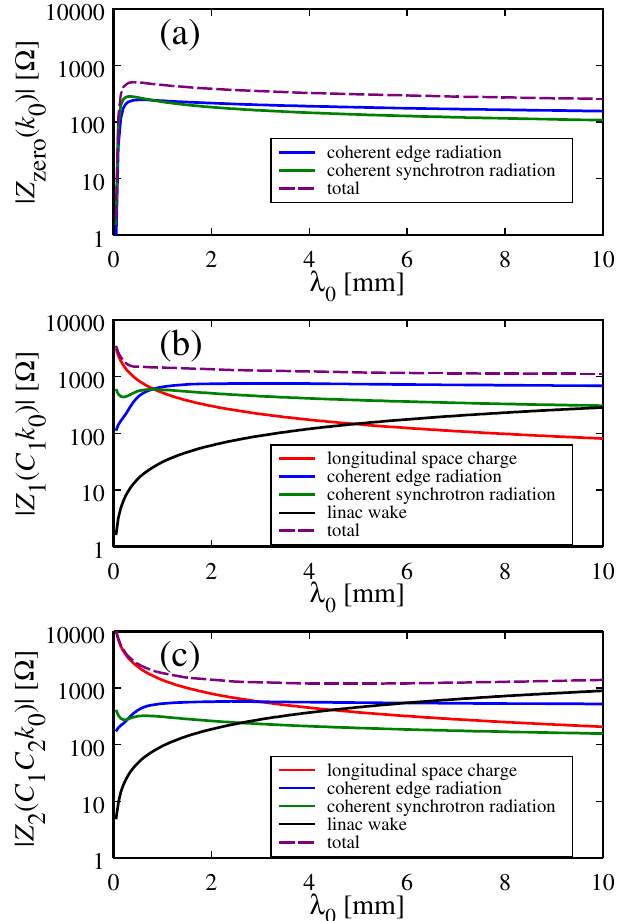
FIG. 3. (Color) Effective impedances experienced by a modula- tion whose wavelength and wave number before compression are (cid:6) 0 and k 0 , respectively. (a) Impedance experienced before com- pression in BC1. (b) Impedance experienced between BC1 and BC2. (c) Impedance experienced after full compression in